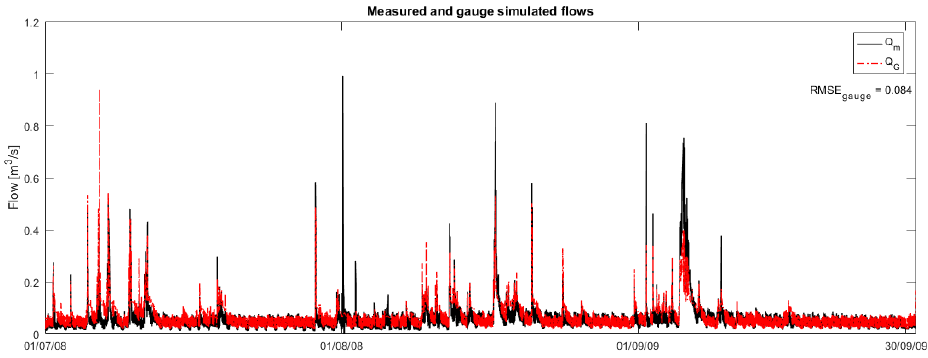
Figure 10. Measured flows (Q m ) and gauge simulated flows (Q G ) from 1 July 2008 until 30 September 2008.